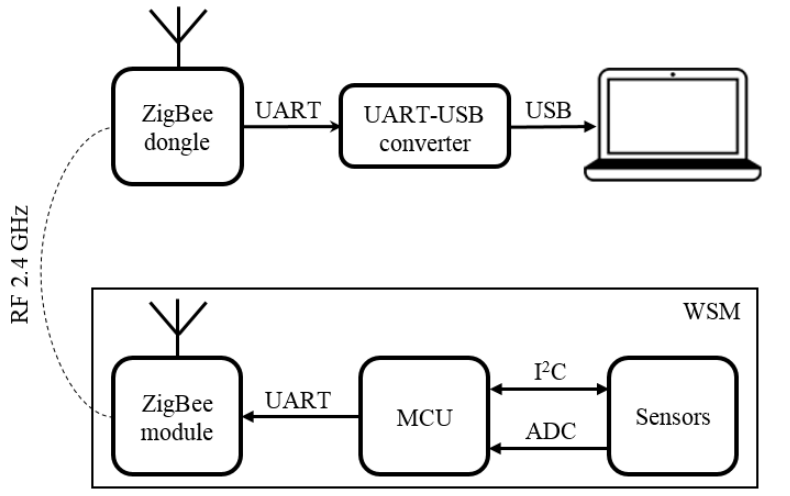
Figure 1. The concept of the distributed measurement system using wireless low-power monitoring devices.